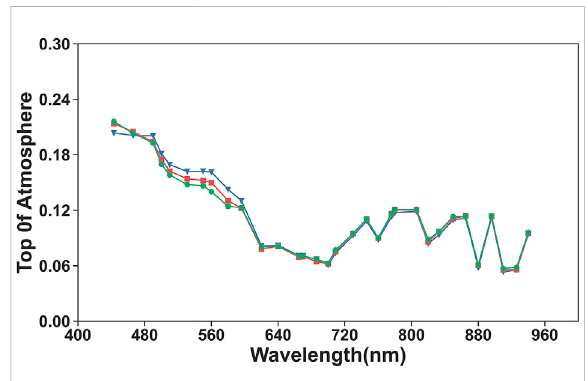
FIGURE 4 Comparison of the TOA re fl ectance curves. Blue is clear sky pixels, red is visually interpreted as clear sky pixels that are classi fi ed as cloud pixels by all models, and green is identi fi ed as cloud pixels by only